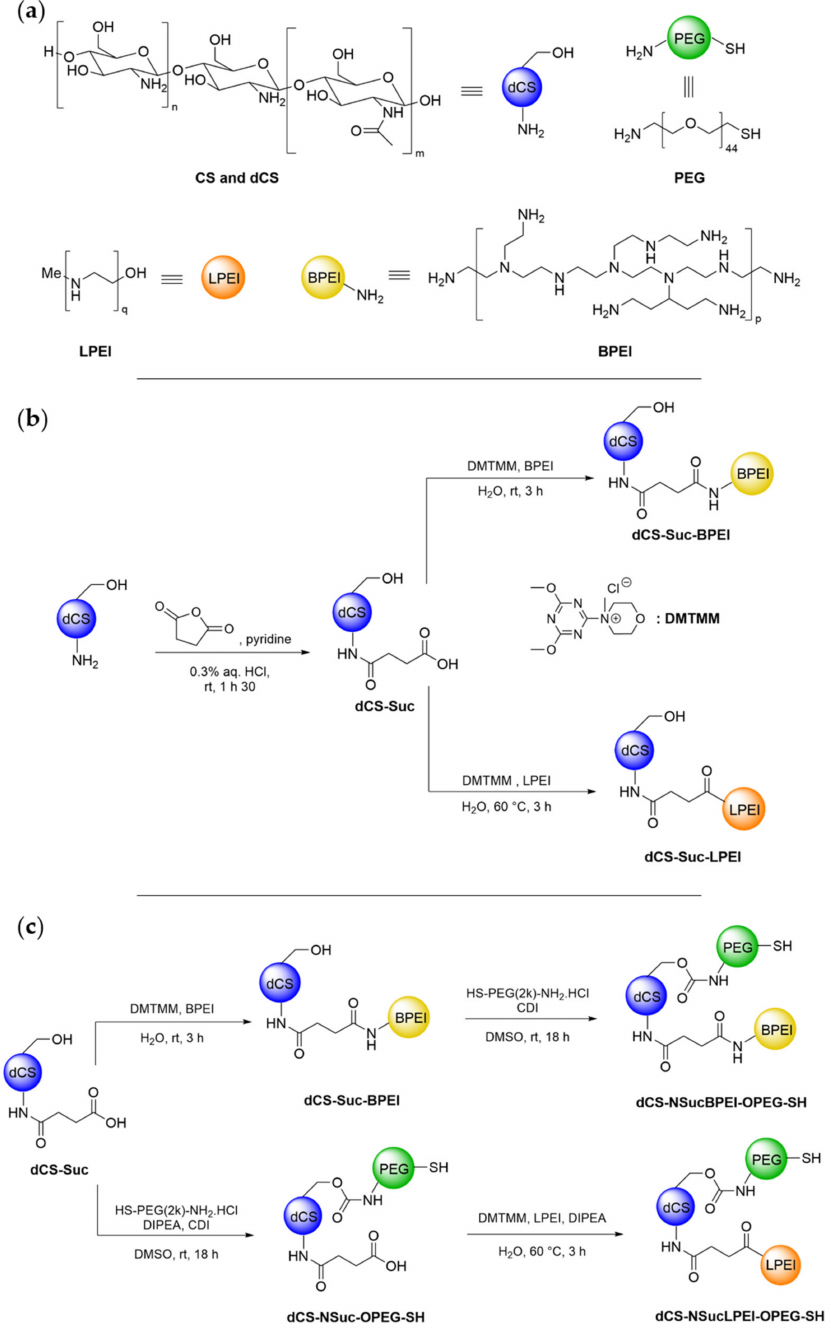
Figure 2. Synthesis of covalent dCS-PEI conjugates. ( a ) Structures of chitosan (CS, DD ≈ 80%), depolymerized chitosan (dCS, DD ≈ 80%), polyethylene glycol (PEG, 2 kDa), and branched (BPEI, 1.8 kDa) and linear (LPEI, 2.5 kDa) polyethylenimine. ( b ) Synthesis of dCS-Suc-BPEI and dCS-Suc- LPEI using a succinyl linker (Suc) and DMTMM as water-soluble coupling agent. ( c ) Synthetic pathways for sequential grafting of BPEI, LPEI, and H 2 N-PEG-SH on dCS-Suc. NSuc: Suc linked to amine groups. OPEG: PEG linked to hydroxyl groups. For detailed representation of the PEI conjugation sites to dCS-Suc, see supporting information, Figure